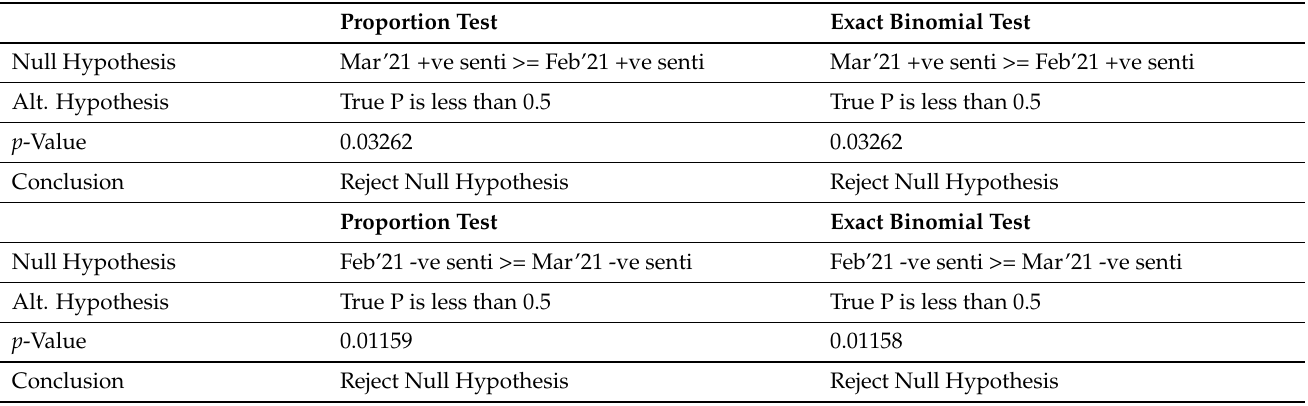
Table 4. Statistical tests for positive and negative sentiment counts in February and March 2021. ( a ) Tests for change in positive sentiment from February to March. ( b ) Tests for change in negative sentiment from February to